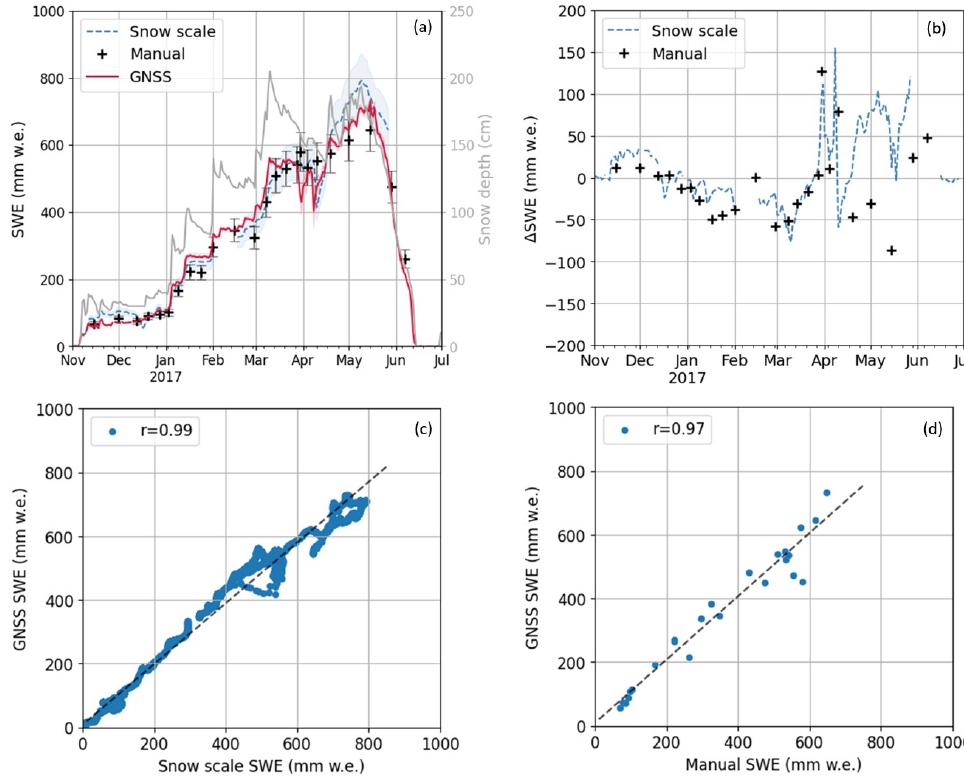
Figure 4. ( a ) Post-processed SWE overlaid with its standard deviation per day from the fixed, high- end GNSS snow monitoring setup at Davos Weissfluhjoch for 2016/17. A relative bias of 10% is added to the snow scale and manual observations. Daily snow depth is given in gray: ( b ) differences to reference sensors observations; correlation with ( c ) the snow scale; and ( d ) manual observations.